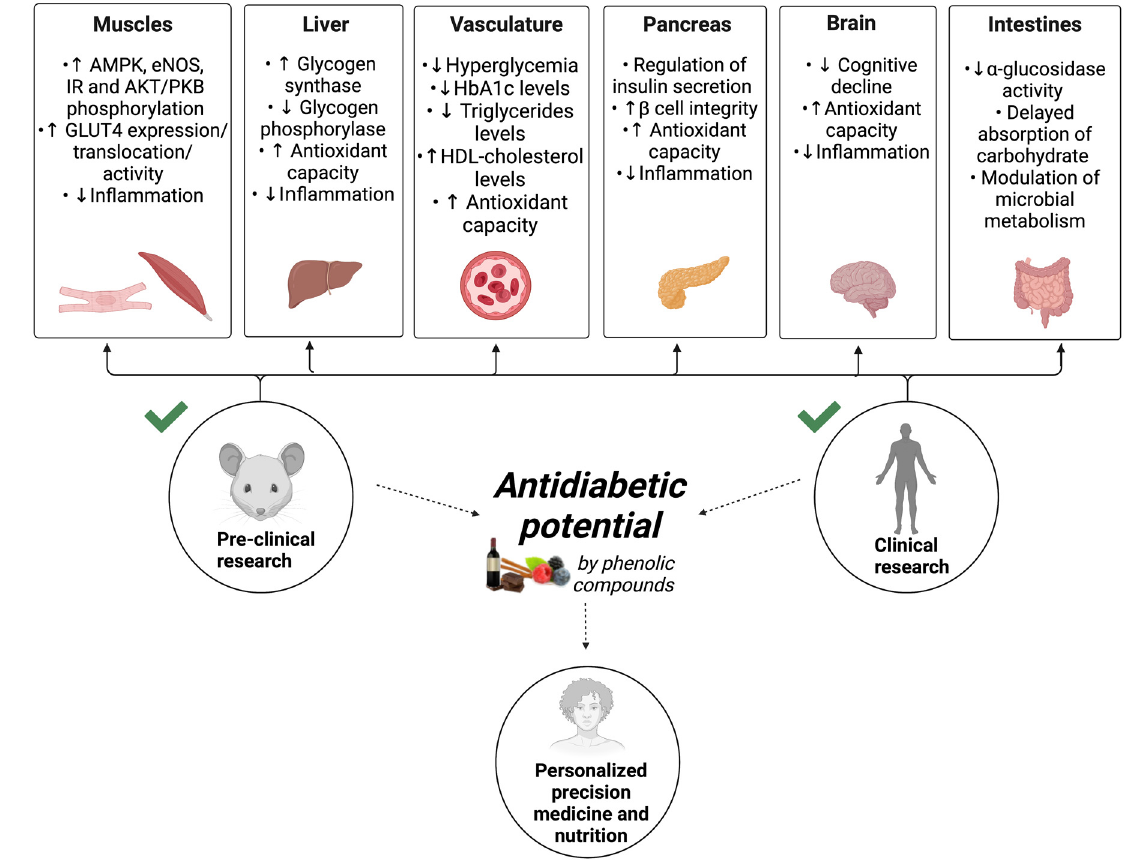
Figure 4. Underlying mechanisms of phenolic compounds against diabetes and its associated complications described herein in pre-clinical and clinical diabetes studies. Future research should focus on personalized studies in precision medicine and nutrition to be applied among persons of different sexes and across different age groups. AMPK: adenosine mono phosphate kinase; AKT/PKB: protein kinase B; eNOS: endothelial nitric oxide synthase; GLUT4: glucose transporter-4; HbA1c: glycosylated hemoglobin; IR: insulin receptor. The arrows point to the final objective of the researches: to prove the antidiabetic potential of phenolic compounds.